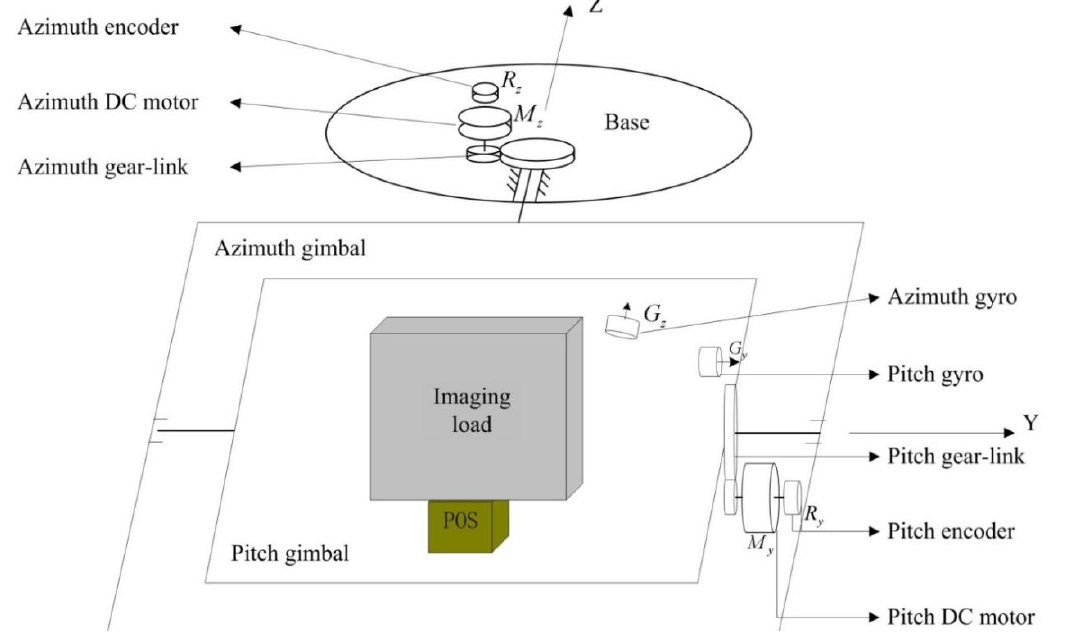
Figure 2. Schematic diagram of a two-axis ISP’s working